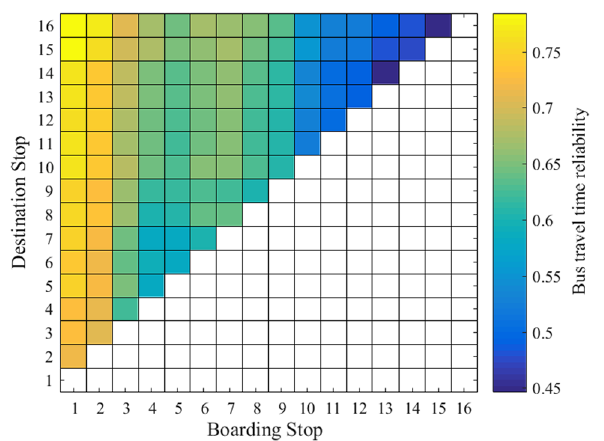
Fig. 11 Bus travel time reliability in different O–D pairs